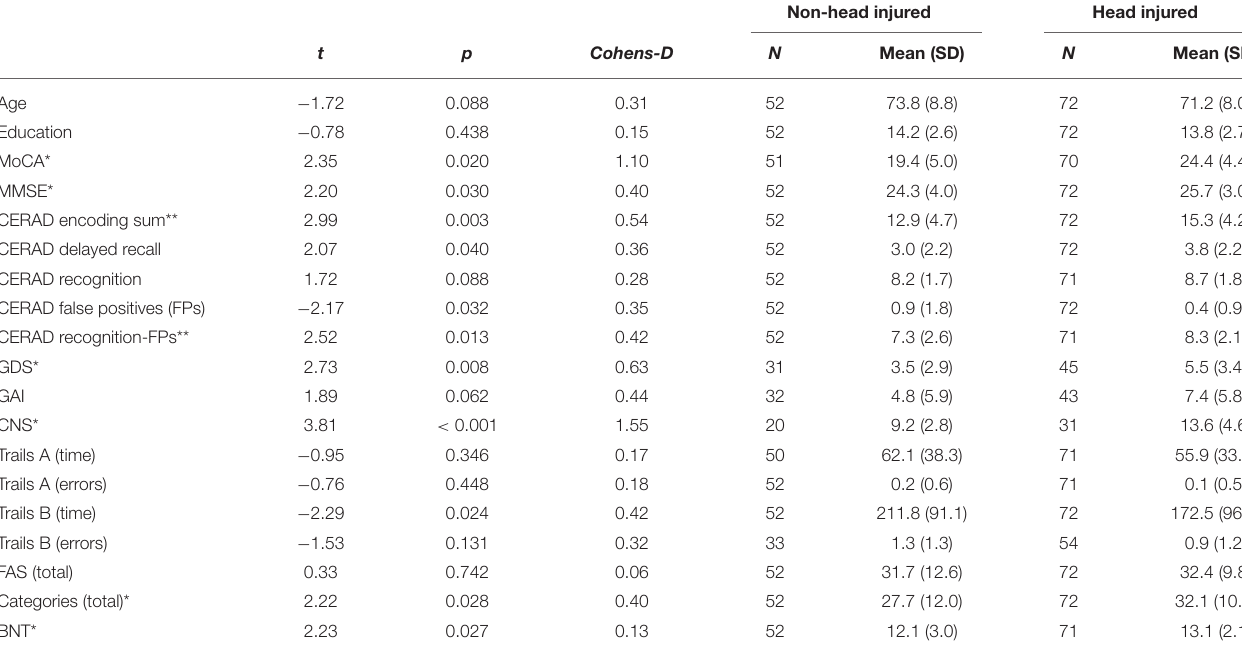
TABLE 1 | Demographic and neuropsychological data for non-head injury and head injury